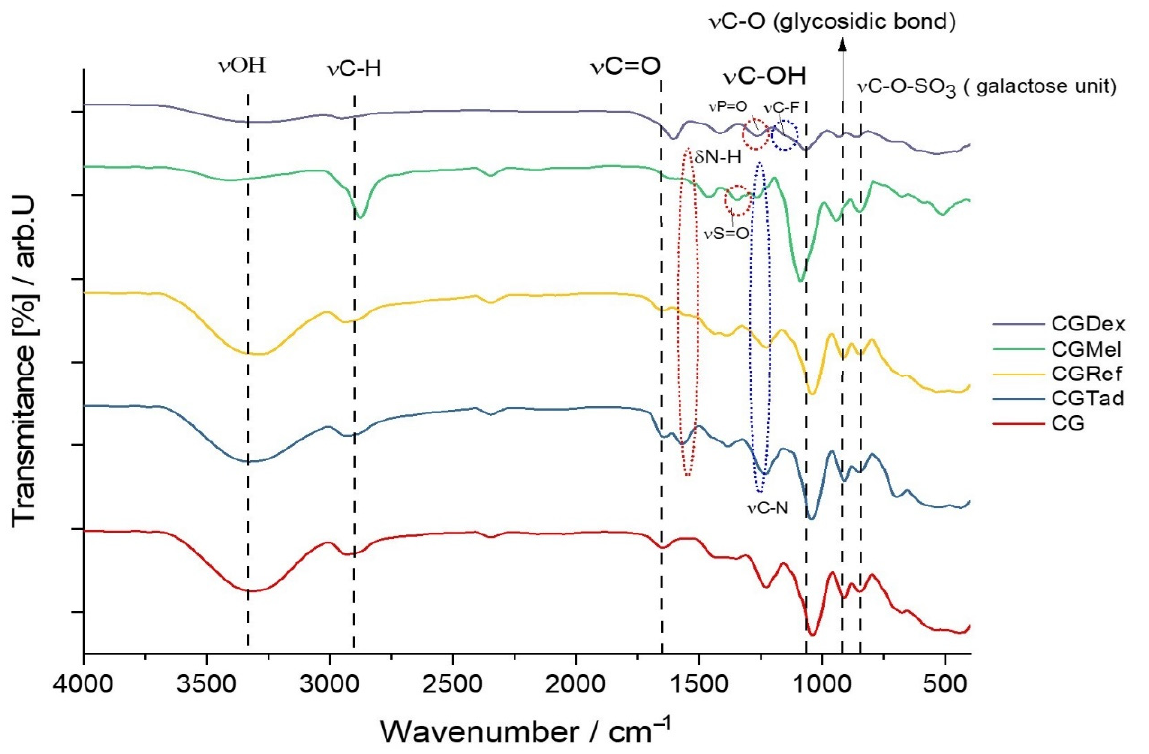
Figure 2. FTIR spectra for the following membranes CG, CGDex, CGMel, CGref, and CGTad. Wavenumber values of the most relevant peaks for each membrane containing anti- inflammatory drugs are shown in Table 2. Table 2. Wavenumber values of most relevant peaks found in FT-IR spectra of analyzed mem- branes.